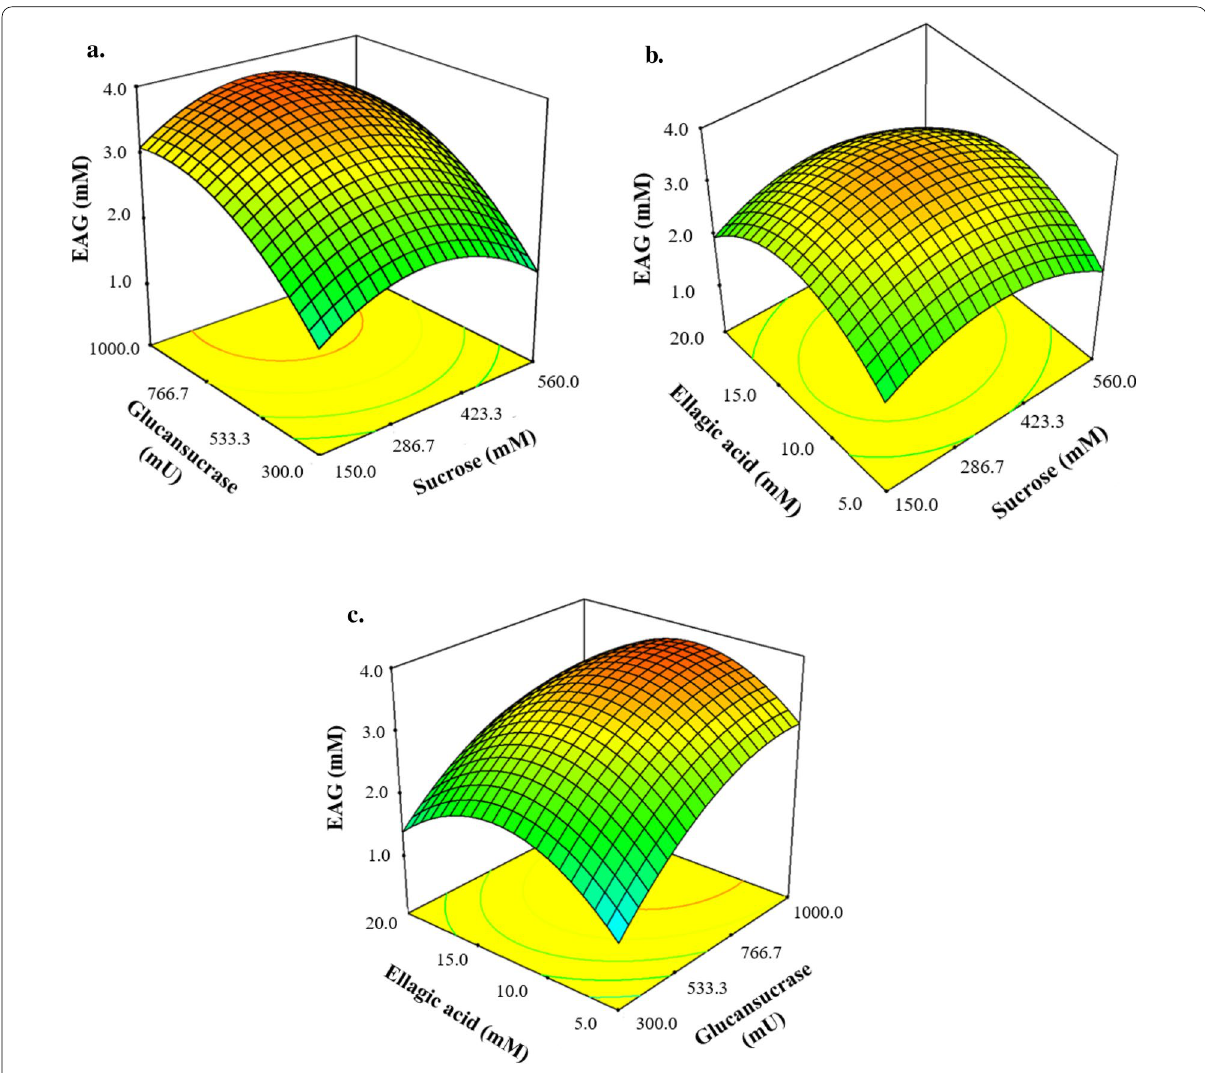
Fig. 2 Response surface and contour plots of ellagic acid glucoside (EAG) production. Mutual interactions between glucansucrase and sucrose ( a ), between ellagic acid and sucrose ( b ), and between ellagic acid and glucansucrase ( c ) are shown. The synthesis of ellagic acid glucoside was